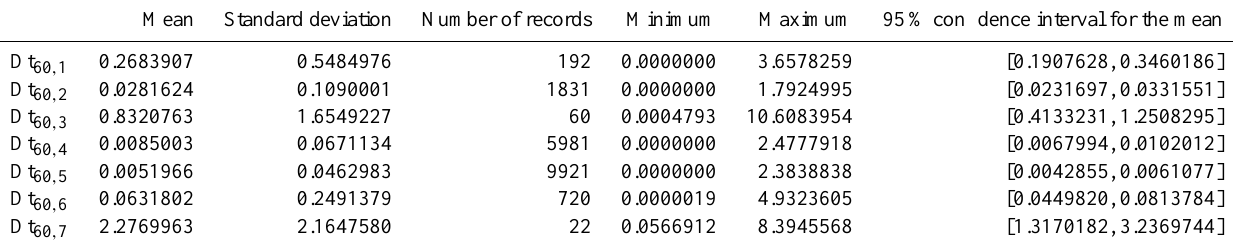
Table 7. Statistics of Dt 60 ,i . Mean Standard deviation Number of records